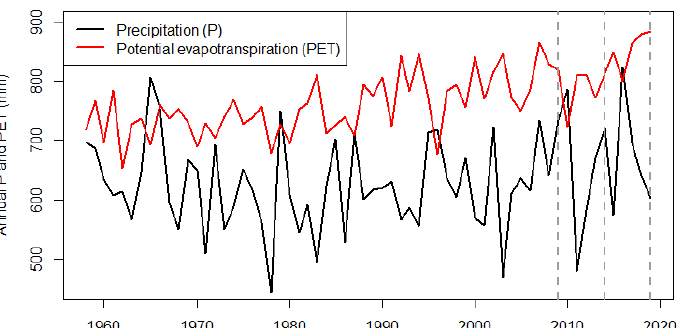
Figure A1. Annual precipitation sum (P, solid black line) and annual potential evapotranspiration (PET, solid red line) in the study area using gridded climate data [27]. Dashed vertical lines indicate the three measurements—2009, 2014 and 2019. P larger PET indicate positive water balance and water surplus (i.e., more rainfall than energy input for water evapotranspiration).